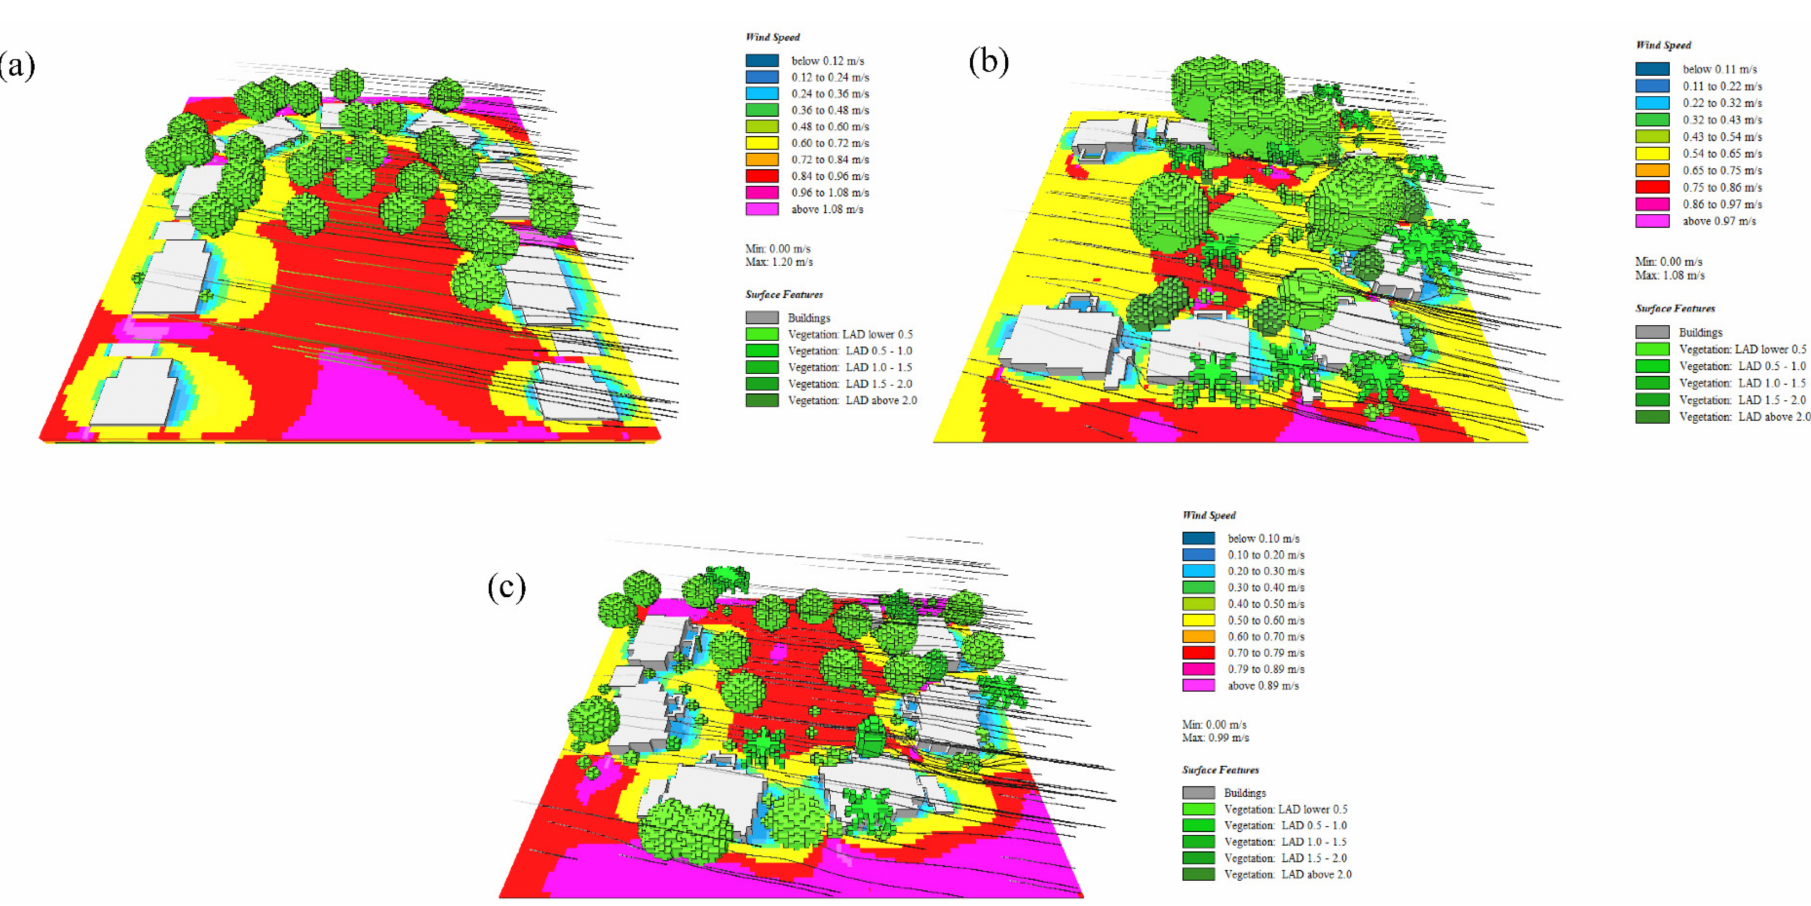
Figure 5. Wind speeds for mesic ( a ), oasis ( b ), and xeric ( c ) landscapes at